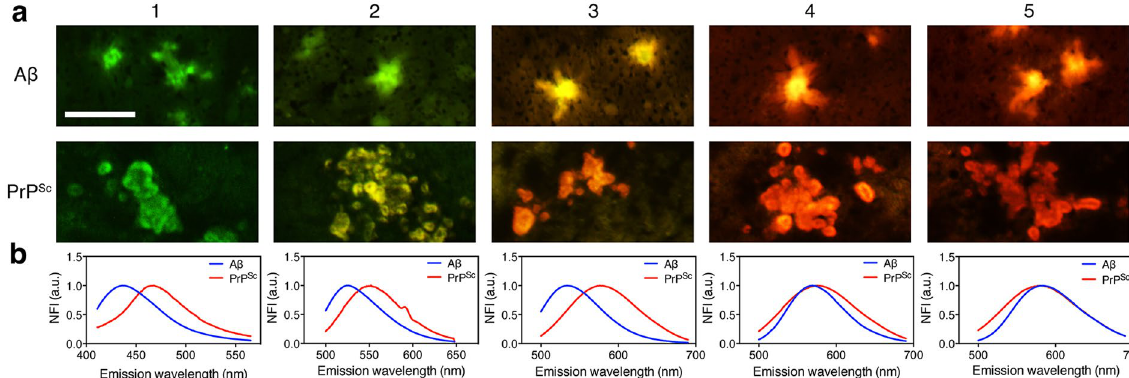
Figure 6. Brain tissue staining with AACA probes 1–5 . ( a ) Real-color fluorescence images of probes bound to A β plaques in the hippocampus of transgenic AD mice or to prion (PrP SC ) plaques in the corpus callosum of prion-infected mice. ( b ) Spectroscopic measurements of the fluorophore emission of representative plaques stained with probes 1–5 . Scale bar = 50 microns.